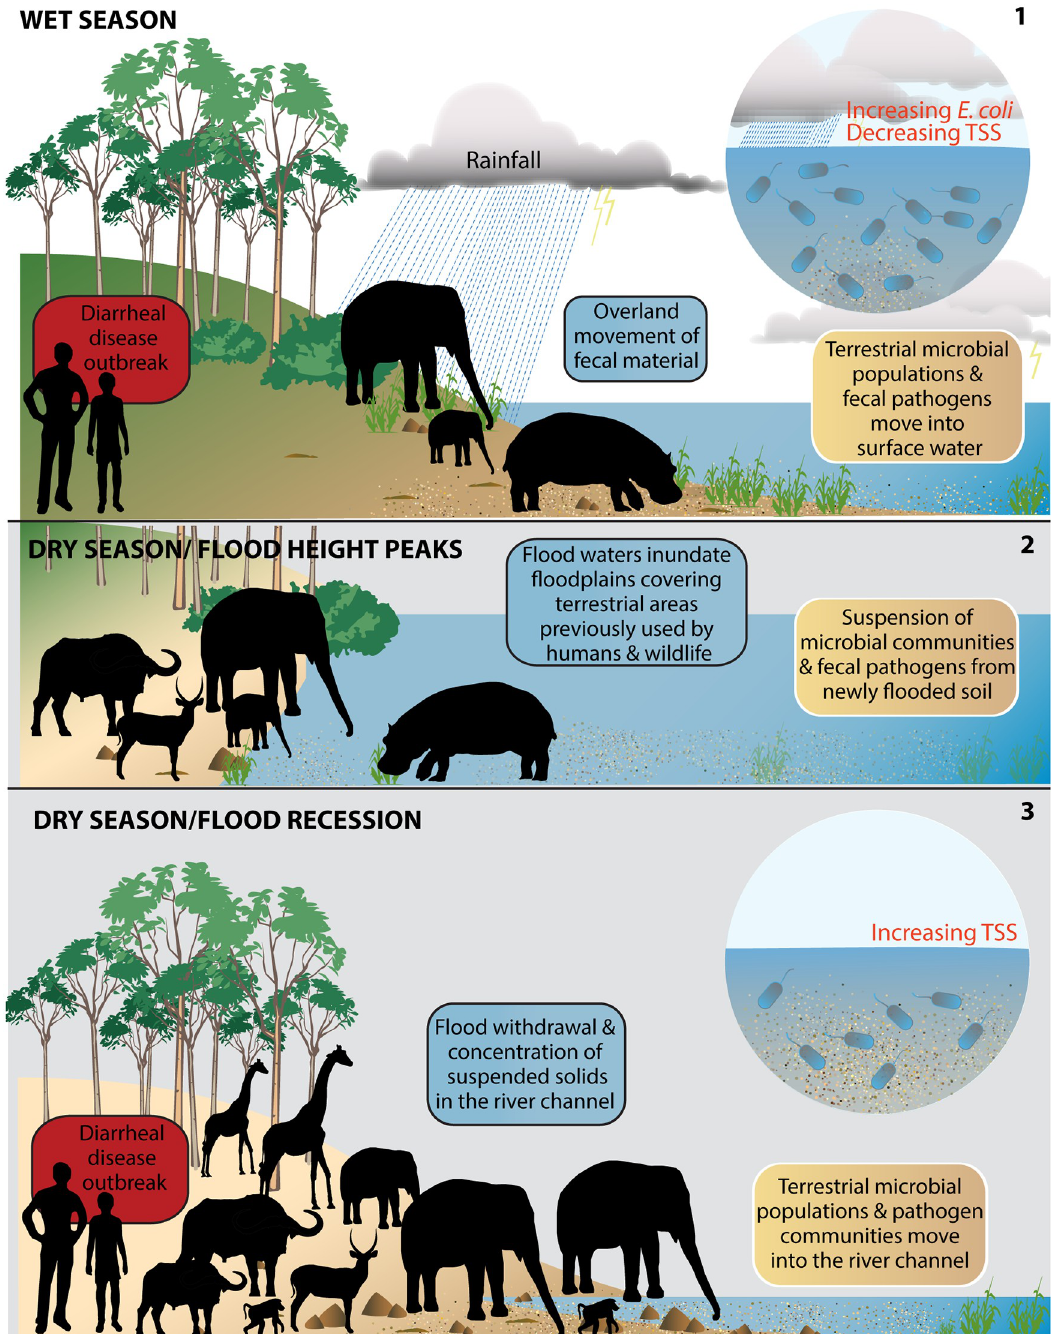
Fig 4. Schematic of rainfall and flood pulse influences on surface water quality and diarrheal disease outbreaks in a flood pulse river system. In these systems, the flood pulse uniquely links aquatic and terrestrial habitats and microbial communities including potential pathogens. During the wet season (panel 1), rainfall moves fecal E . coli (a marker for fecal bacteria) overland from riparian areas into the river channel. As in-river E . coli increases, the number of diarrheal disease case reports increases in the population using municipal water that was obtained from the river (wet season outbreak). During this same period, seasonal pans are filled with rainfall, and water-dependent animals (wildlife and, to a lesser extent, livestock) move out of the riparian area into the interior to utilize forage and water resources. Floodwaters (panel 2) rise and inundate floodplains, incorporating fecal microbial communities on previously dry land areas. With progression of the dry season and no rainfall, water pans in the interior dry up, and water- dependent animals move back to the river’s edge, concentrating fecal material along river floodplains while utilizing the only